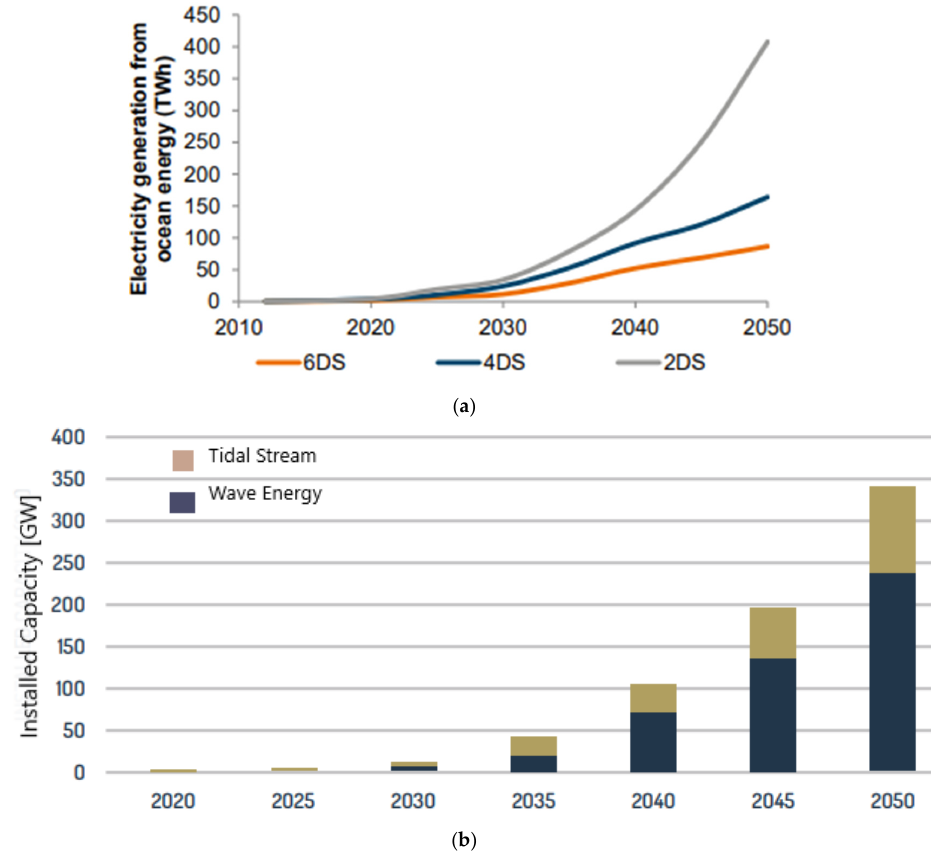
Figure 21. Projected electricity generation and installed capacity: ( a ) electricity generation from ocean energy between 2013 and 2040, and ( b ) ocean energy capacity forecast to 2050 by ETP.